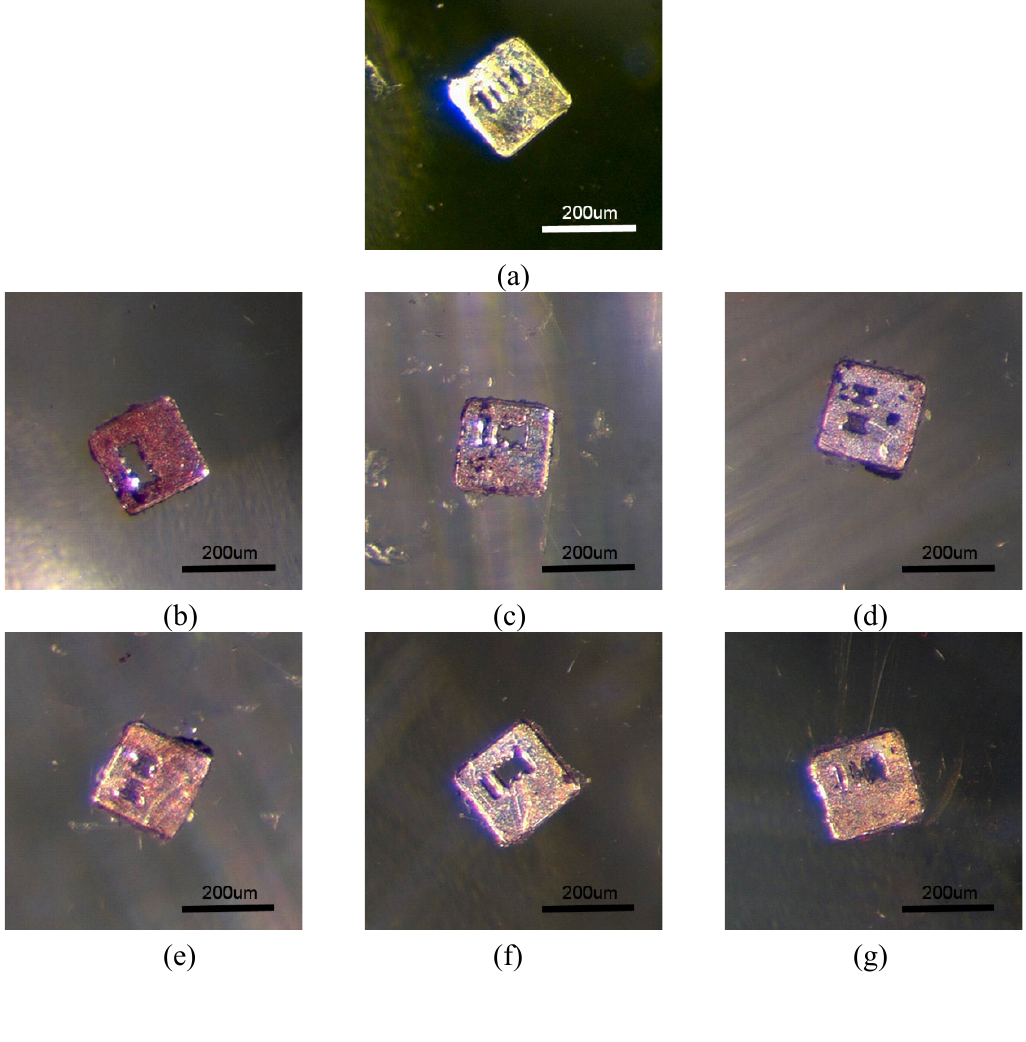
Figure 9. Photographs of ferromagnetic coded micro-carriers with different dilution ratios of 1°Ab after hybridization: (a) negative control; (b) 0; (c) 20; (d) 80; (e) 140; (f) 200; (g)